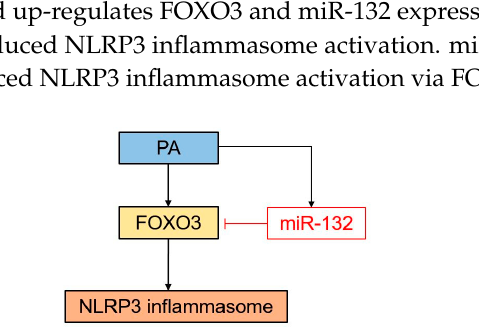
Figure 8. Schematic diagram of the proposed model showing the role of miR-132 in PA-induced NLRP3 inflammasome activation. PA up-regulates activation of the NLRP3 inflammasome, miR-132, and FOXO3. miR-132 negatively regulates NLRP3 inflammasome activation through FOXO3 down-regulation.